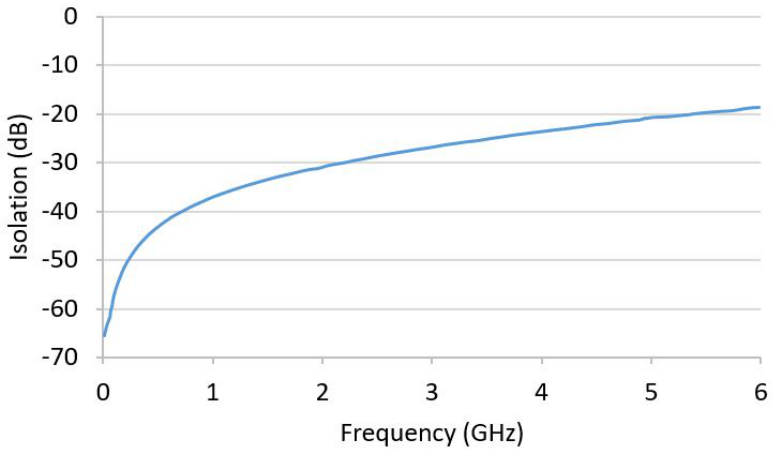
Figure 16. Measured isolation of the SPDT switch.